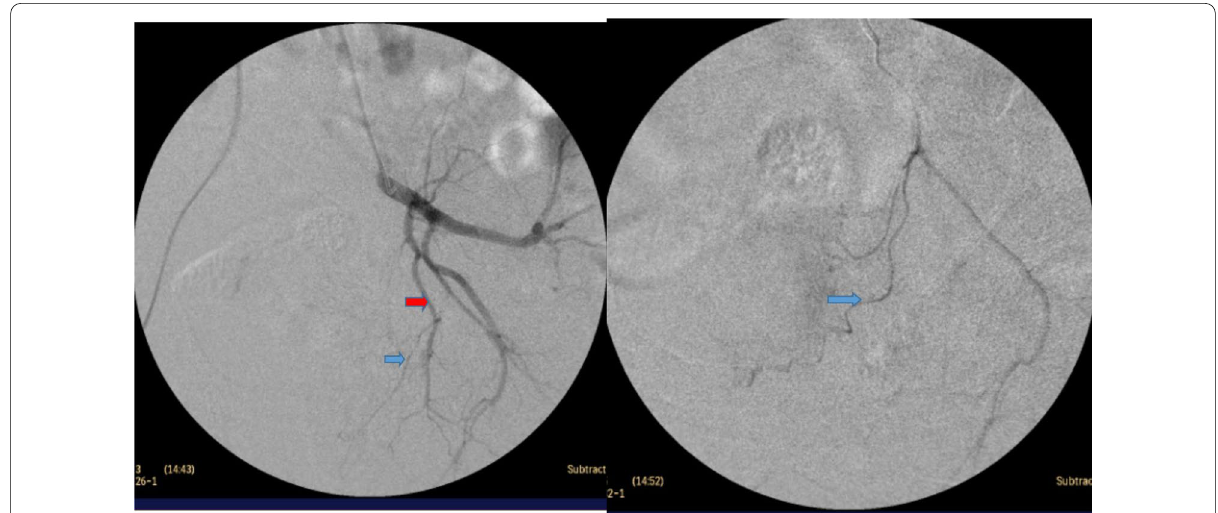
Fig. 3 Angiography images showing the prostatic artery (blue arrow) arising from the left obturator artery (red arrow)